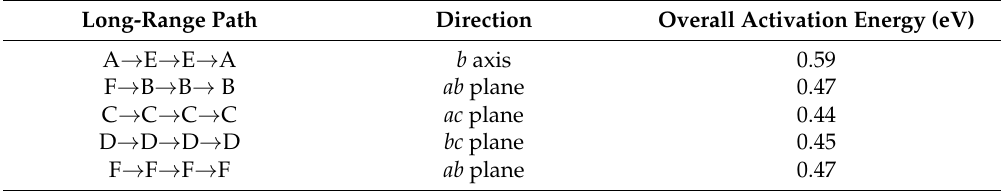
Figure 4. Six different energy profiles (as shown in Figure 3) of Li vacancy hopping between two adjacent Li sites in Li 2 MnO 3 . Table 3. Possible long-range Li ion diffusion paths and their corresponding overall activation